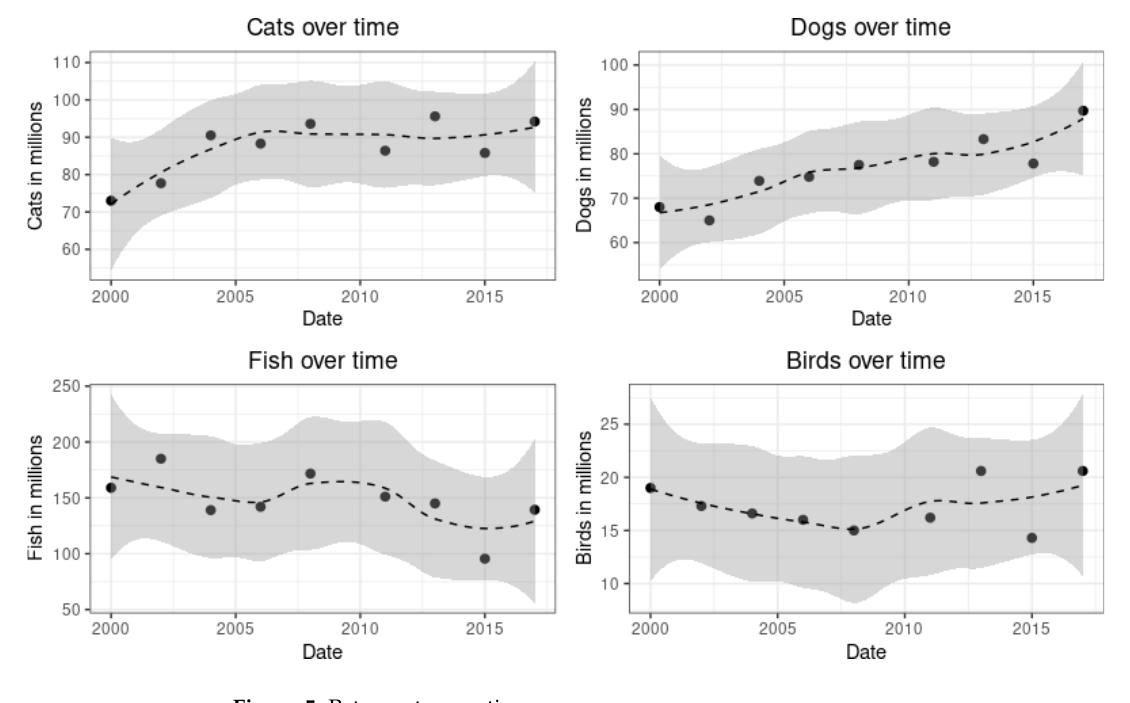
Figure 5. Pet counts over